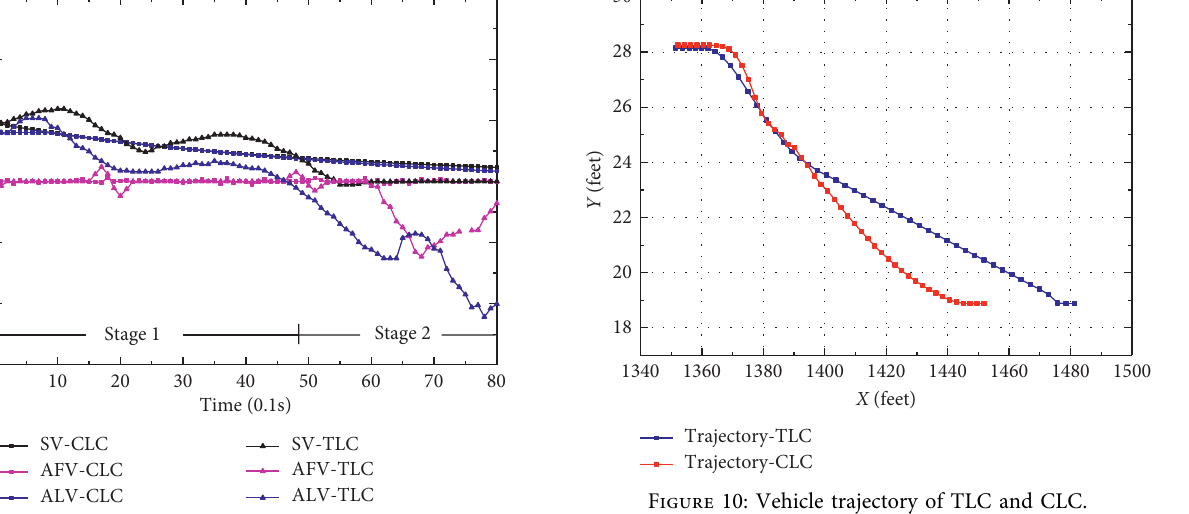
Figure 8: Vehicle accelerations during lane changing.